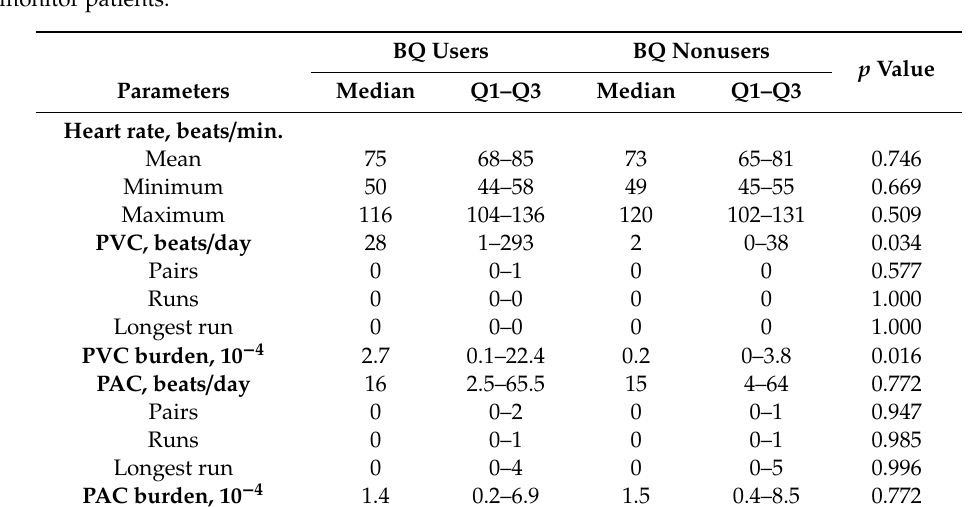
Table 2. Electrocardiographic parameters associated with betel-quid (BQ) use among Holter monitor patients.